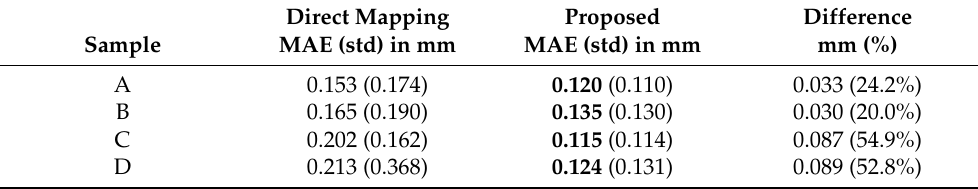
Table 4. Compared MAE (and standard deviation) of the direct mapping versus the proposed virtual reference method with Estrada’s unwrapping algorithm ( τ = 0.8). The last column reports the absolute and percentage